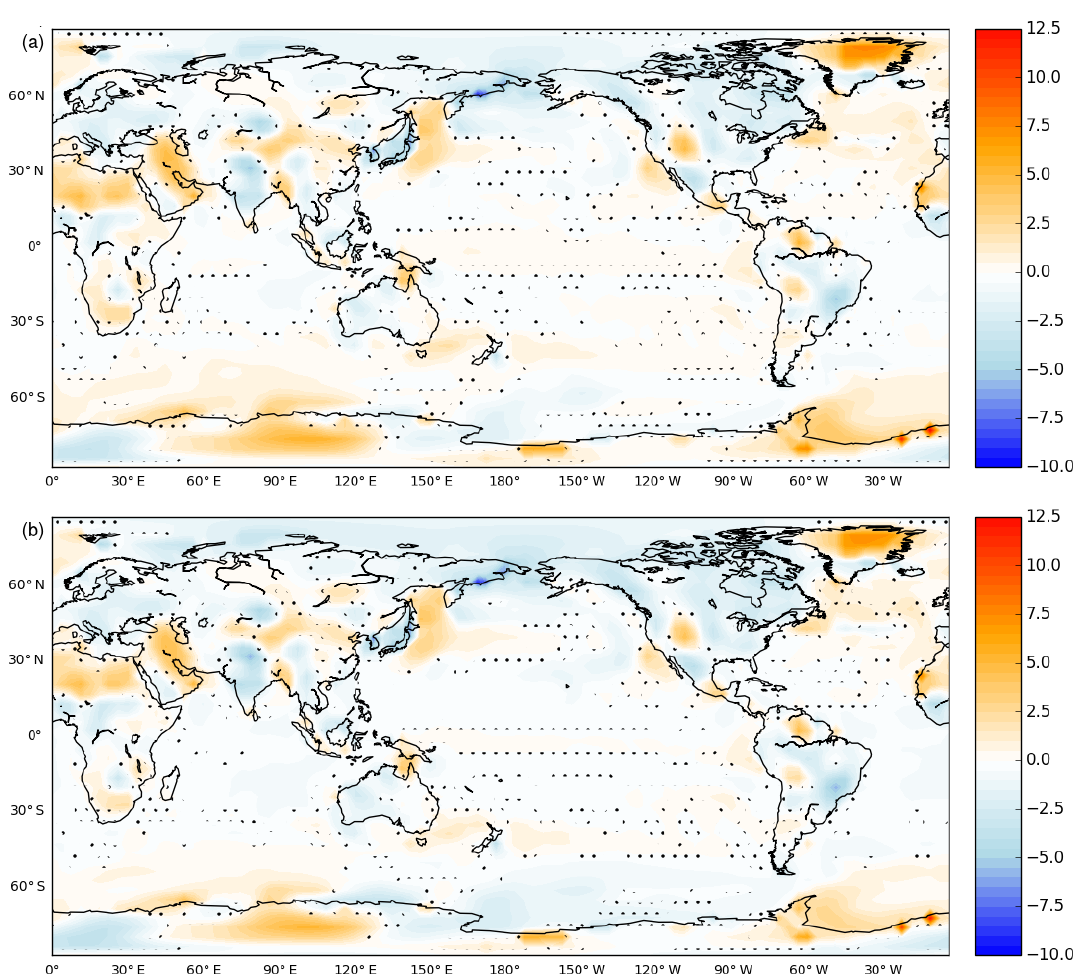
Figure 3. Annual mean SAT ( ◦ C) anomalies between mid-Pliocene simulations with varying boundary conditions. (a) Eoi405_ORB − PlioM1, which shows the contribution of changes in mid-Pliocene paleogeography between PlioMIP1 and PlioMIP2. (b) Comparison (Eoi400 − PlioM1) of mid-Pliocene simulations of both PlioMIP phases, incorporating all the changes from PlioMIP1 to